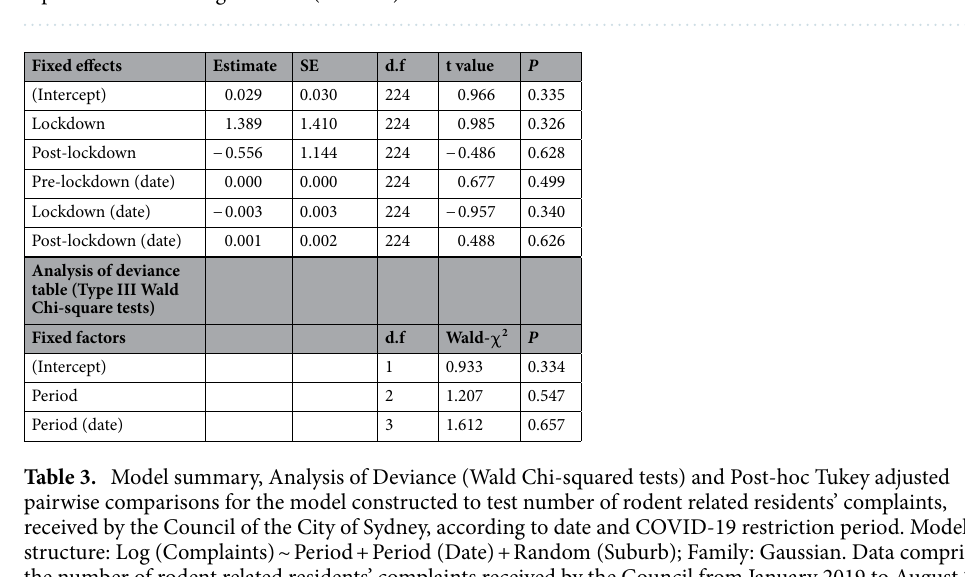
Table 2. Model summary, Analysis of Deviance (Wald Chi-squared tests) and Post-hoc Tukey adjusted pairwise comparisons for the model constructed to test rodent activity scores from bait stations according to date and COVID-19 restriction period. Model structure: Activity Score ~ Period + Period (Date) + Random (Location); Family: Binomial. Data comprised rodent activity score (i.e. low = 0 or high = 1) from 942 bait stations deployed across the Council of the City of Sydney from September 2019 to August 2020. Bold values represent statistical significance ( P < 0.05).